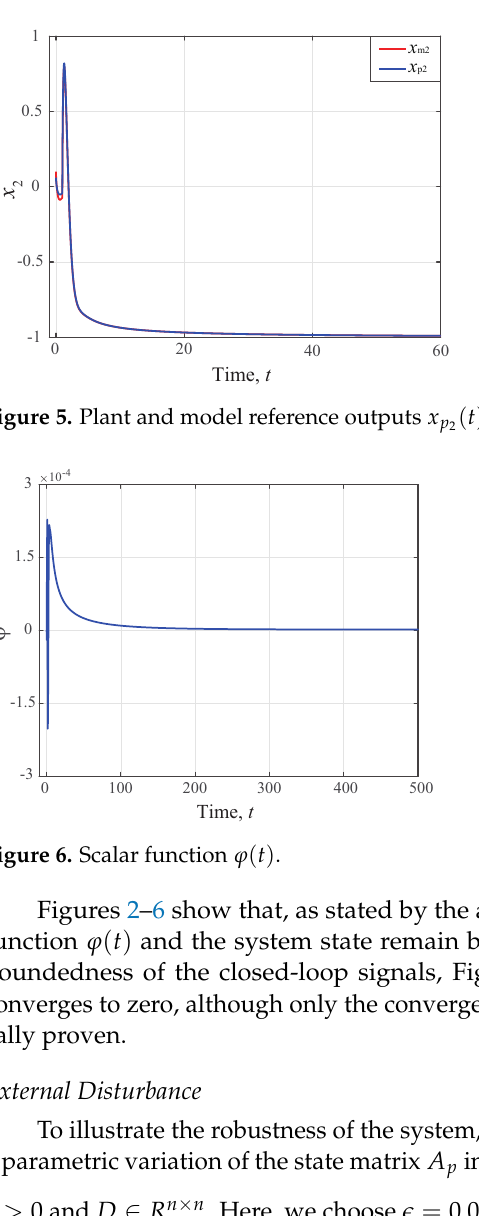
Figure 4. Plant and model reference outputs x p